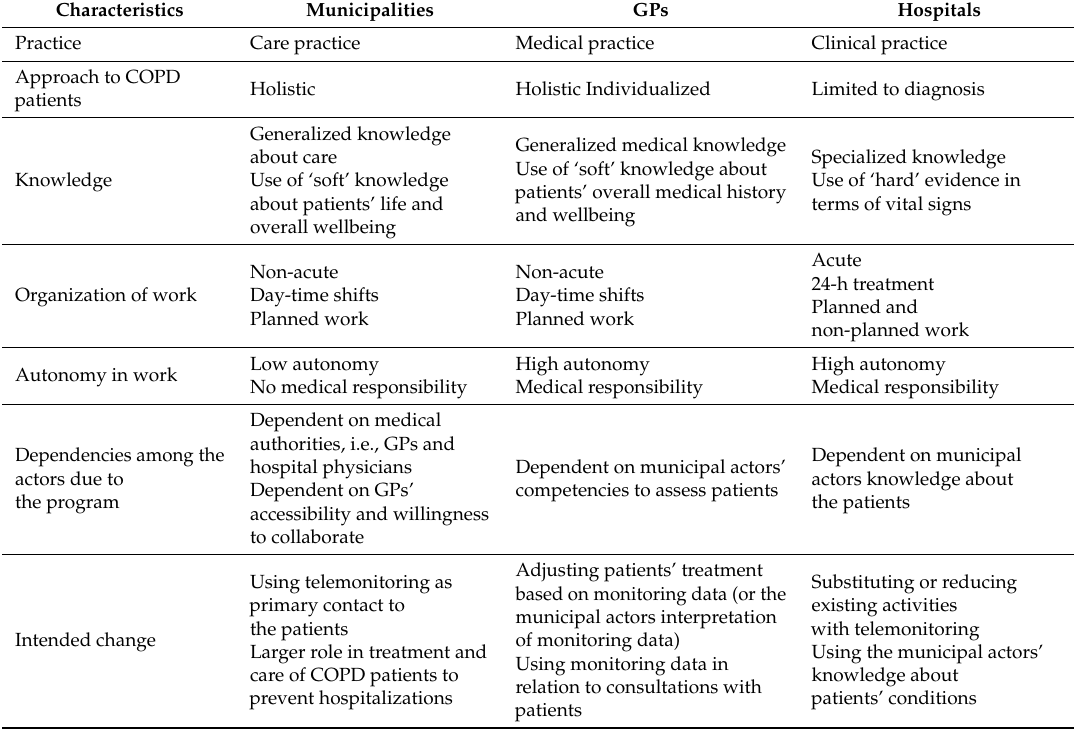
Table 1. Main characteristics of practices and approaches to COPD